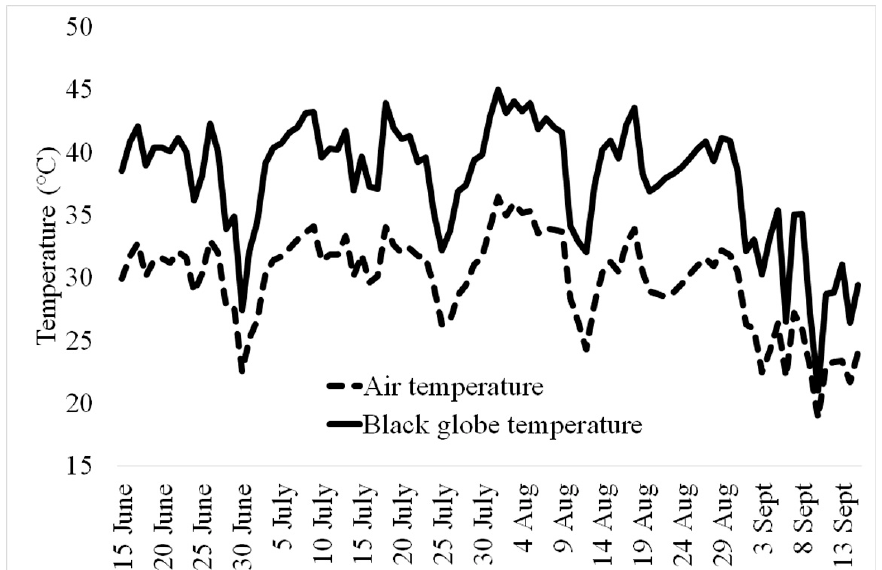
Figure 1. Air temperature (continuous line) and black globe temperature (dashed line) measured during the working time of the day (8:00 a.m.–5:00 p.m.) in the three work sites involved in the study during the summer 2017.